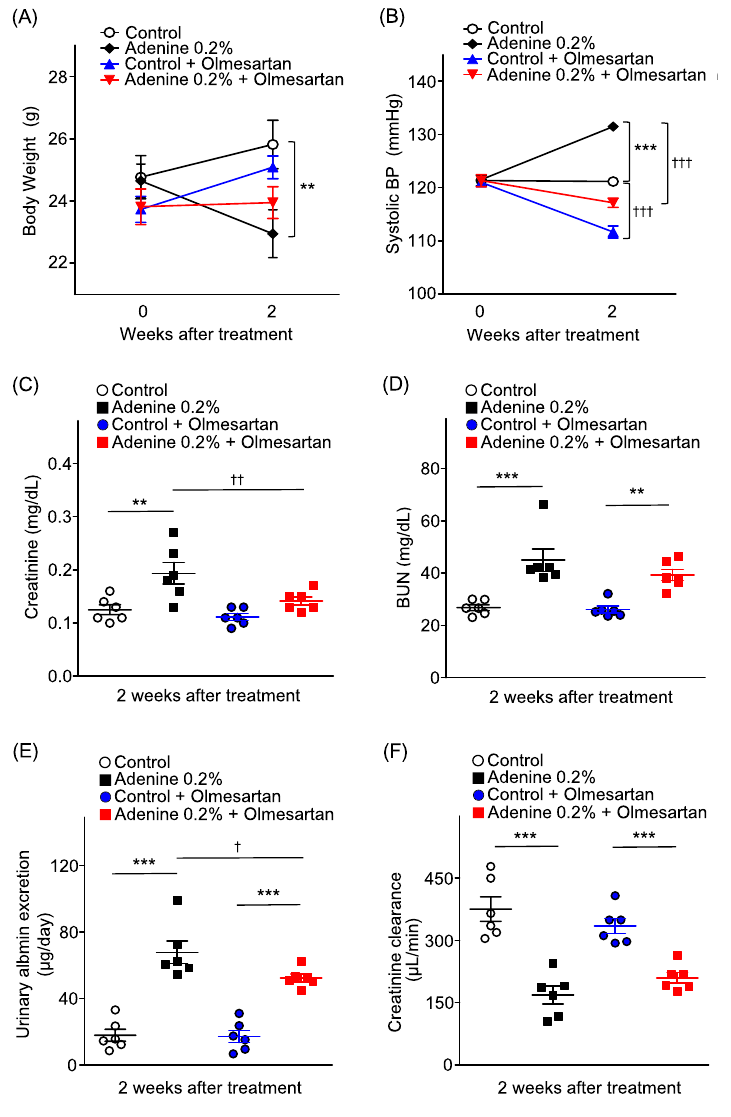
Figure 5. Effects of olmesartan administration on body weight, blood pressure, and renal function. ( A ) Body weight and ( B ) blood pressure in control, adenine, control-olmesartan, and adenine-olmesartan groups. ( C ) Plasma creatinine level, ( D ) plasma BUN level, ( E ) urinary albumin excretion, and ( F ) creatinine clearance in control, adenine, control-olmesartan, and adenine-olmesartan groups. Values are expressed as mean ± standard error of the mean (six mice per group). P values, versus control: * P < 0.05; ** P < 0.01; *** P < 0.001; versus without olmesartan: † P < 0.05; †† P < 0.01; ††† P < 0.001. BP, blood pressure; BUN, blood urea